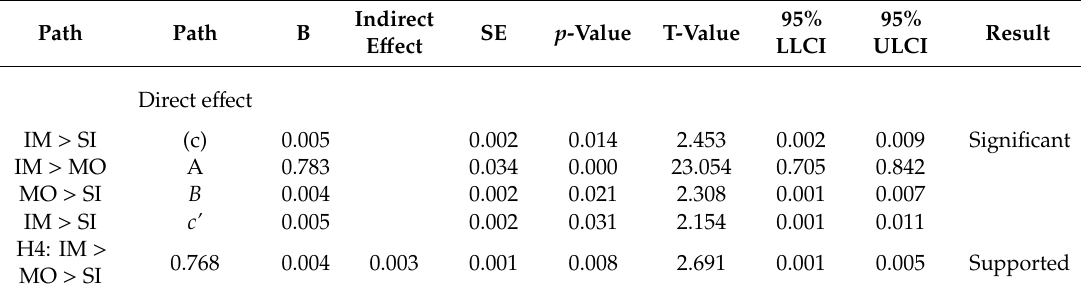
Table 9. The Indirect relationship between mediation e ff ect and hypothesis